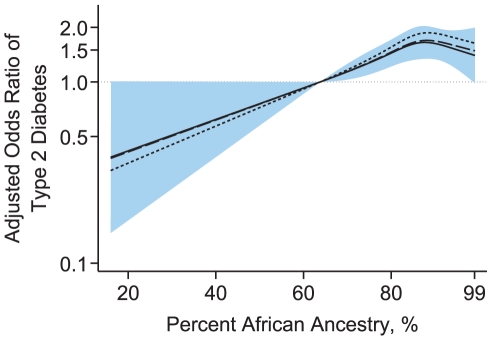
Odds ratio of type 2 diabetes by African ancestry in the ARIC and JHS studies.Odds ratios were based on restricted cubic splines with knots at the 5th, 35th, 65th and 95th percentiles. The reference was set at the 5th percentile (63.8%) of the African ancestry distribution. The odds ratio was adjusted for age, sex and study (shot-dashed line), and further adjusted for socioeconomic status, including education level, family income, and occupations (long-dashed line). The solid line indicates the odds ratio adjusted for age, sex, study, socioeconomic status, and BMI; the shaded area represents its 95% confidence intervals.